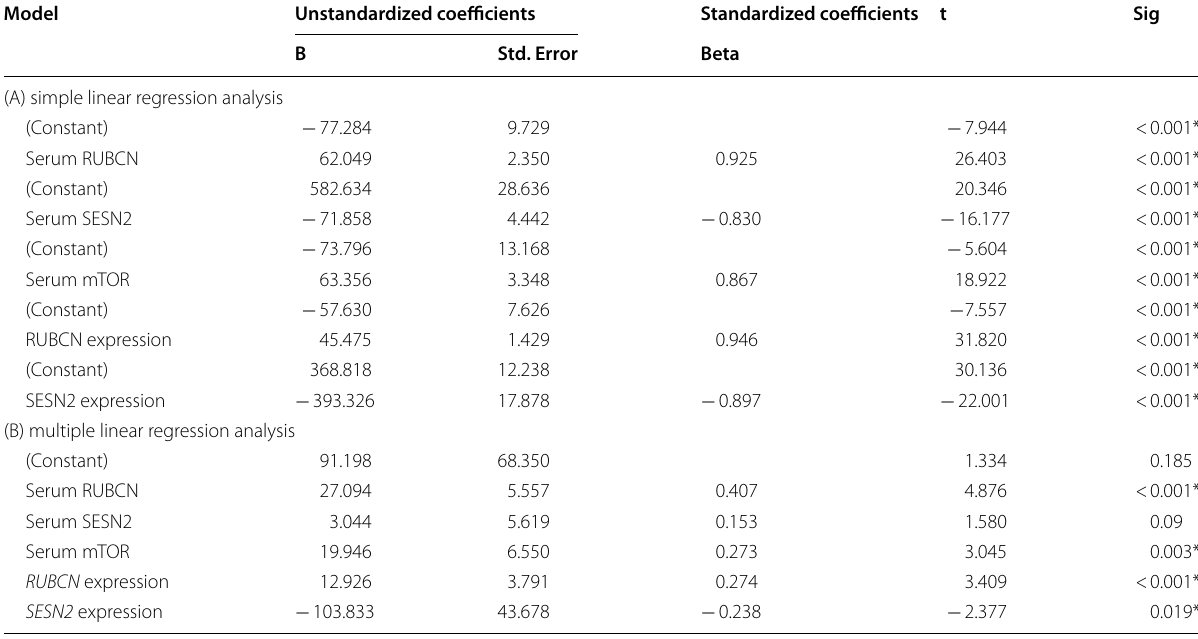
Table 4 Linear regression analysis test results for evaluation of the ability of serum RUBCN, serum SESN2, serum mTOR, RUBCN mRNA expression and SESN2 mRNA expression to predict nephropathy in diabetic patients